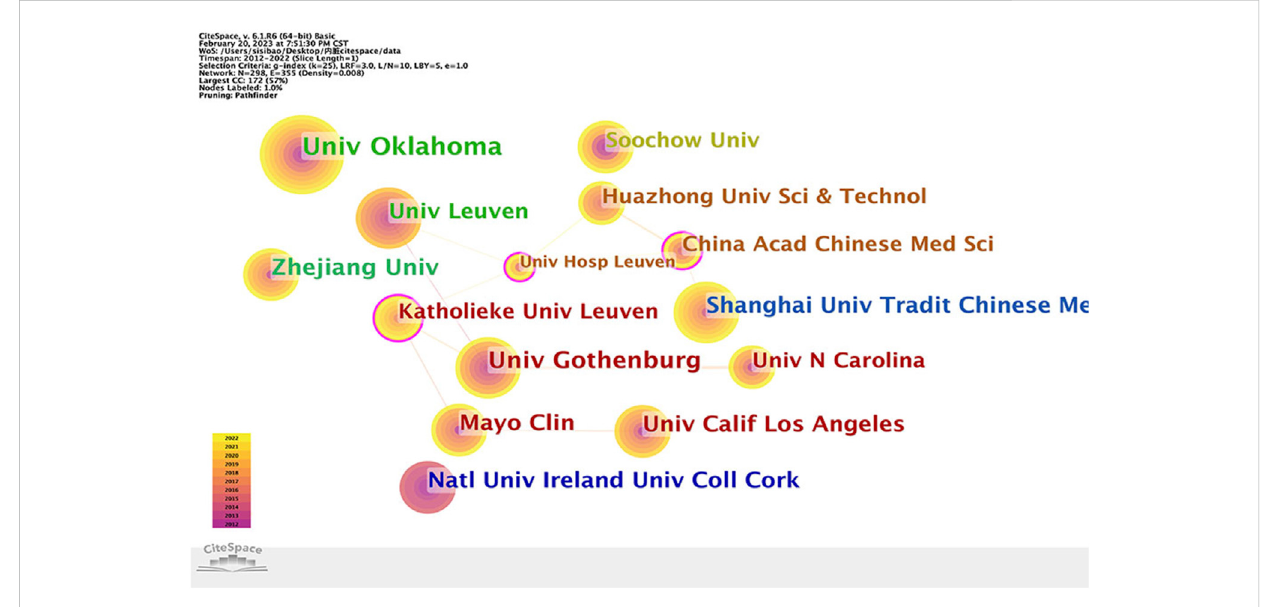
FIGURE 4 Institutions ’ collaboration network of research on IBS and the visceral hypersensitivity.